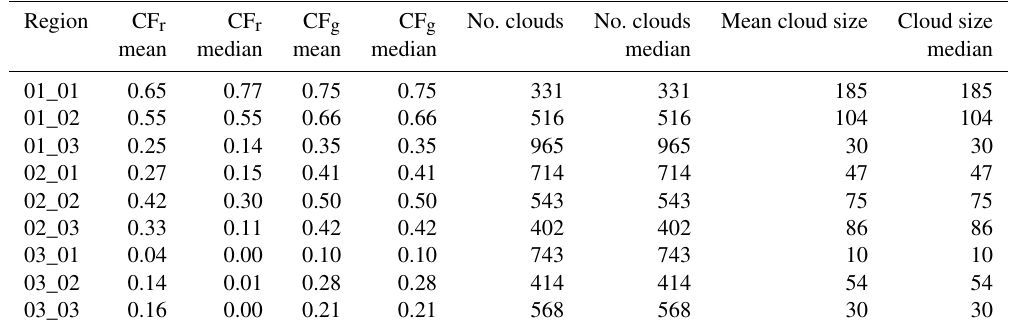
Table A2. Cloud metrics for each sub-region calculated from synthetic data. Note that no standard deviation is provided as only one synthetic- based image is used to calculate the cloud metrics. Cloud size is in units of VIIRS